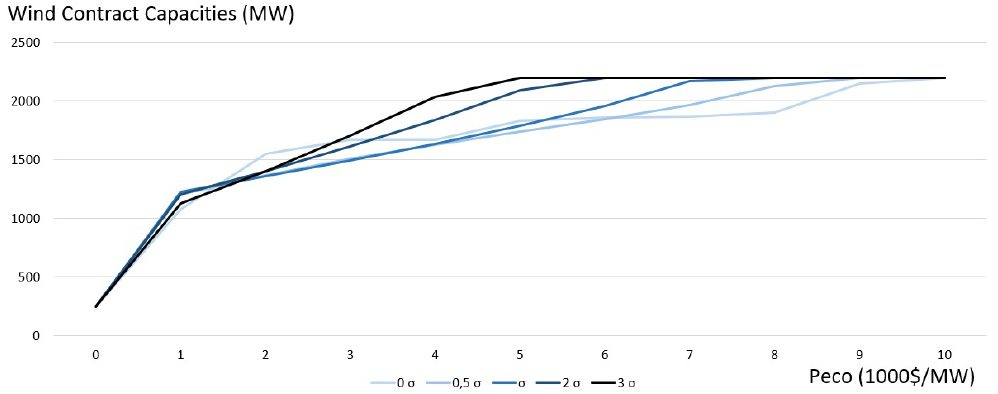
Figure 12. Variation of the optimal wind energy contract capacity with respect to P eco and σ in case of gamma distribution (own